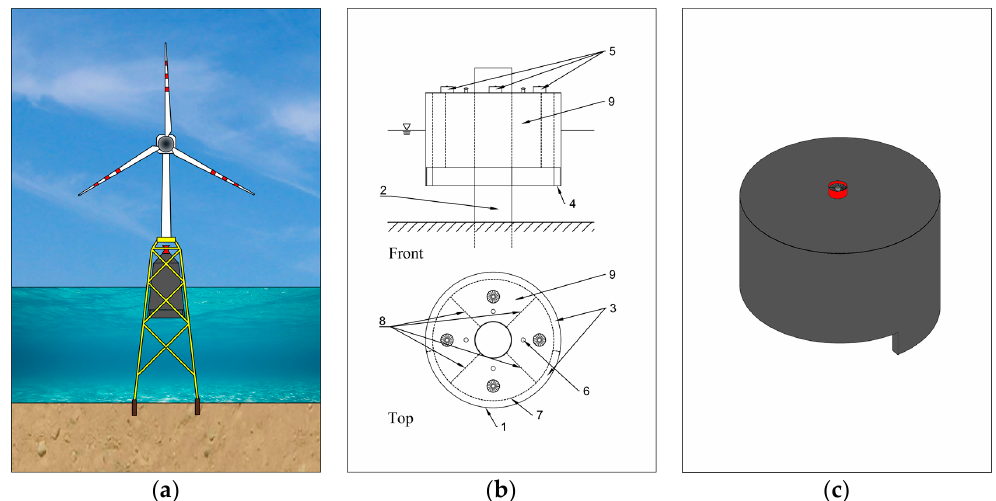
Figure 1. Proposed hybrid wind-wave energy converter for jacket-frame offshore wind substructures: ( a ) conceptual representation of the hybrid model; ( b ) front and top views of the prototype showing its different parts; and ( c ) a perspective view of the WEC sub-system.